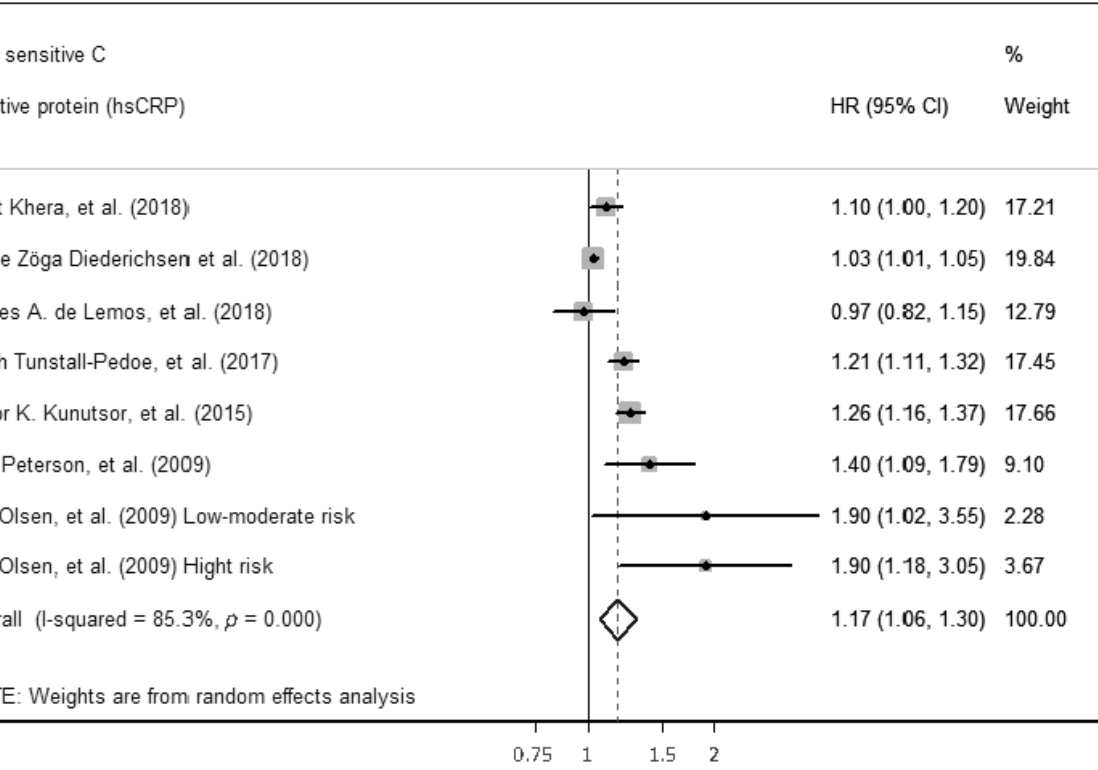
Figure 2. Forest plot of studies for hs-CRP prediction of CVD among middle-aged adults without a prior CVD history or symptoms [16,17,19,20,26,38,39].